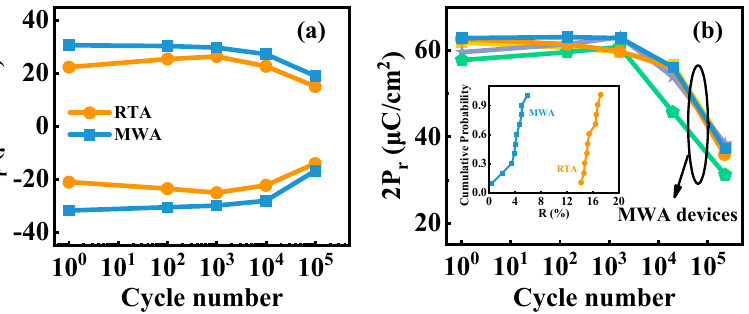
Figure 2. Ferroelectric characteristics of the RTA and MWA devices. ( a ) Electric field cycles perfor- mance. ( b ) Twofold remanent polarization (2Pr) versus the electric field cycles of the MWA capacitors. The inset is the statistical plot of the degree of wake-up (R) effect.